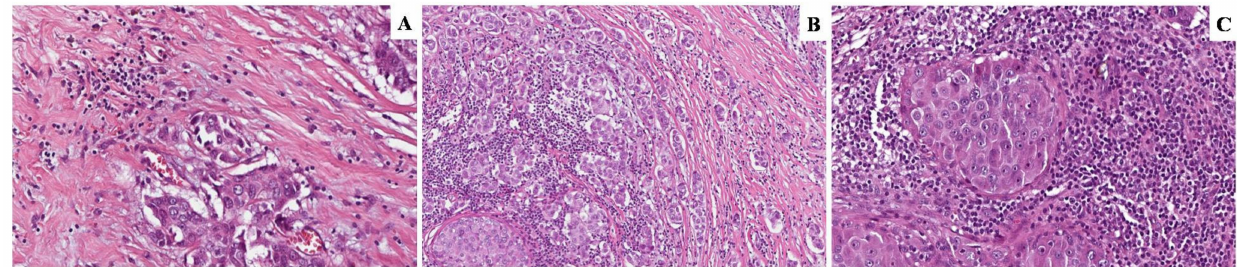
Figure 1. Hematoxylin and eosin (H&E) stained sections illustrating different TILs distribution in our series. ( A ) Invasive breast carcinoma with low TILs (0–10%) in stromal tissue within the tumor (H&E, × 10). ( B ) Another case in our series demonstrating increased TILs in tumor stroma, categorized as intermediate (11–40%) (H&E, × 10). ( C ) High TILs (>40%) in tumor stroma are depicted in this invasive breast cancer case (H&E, × 20).